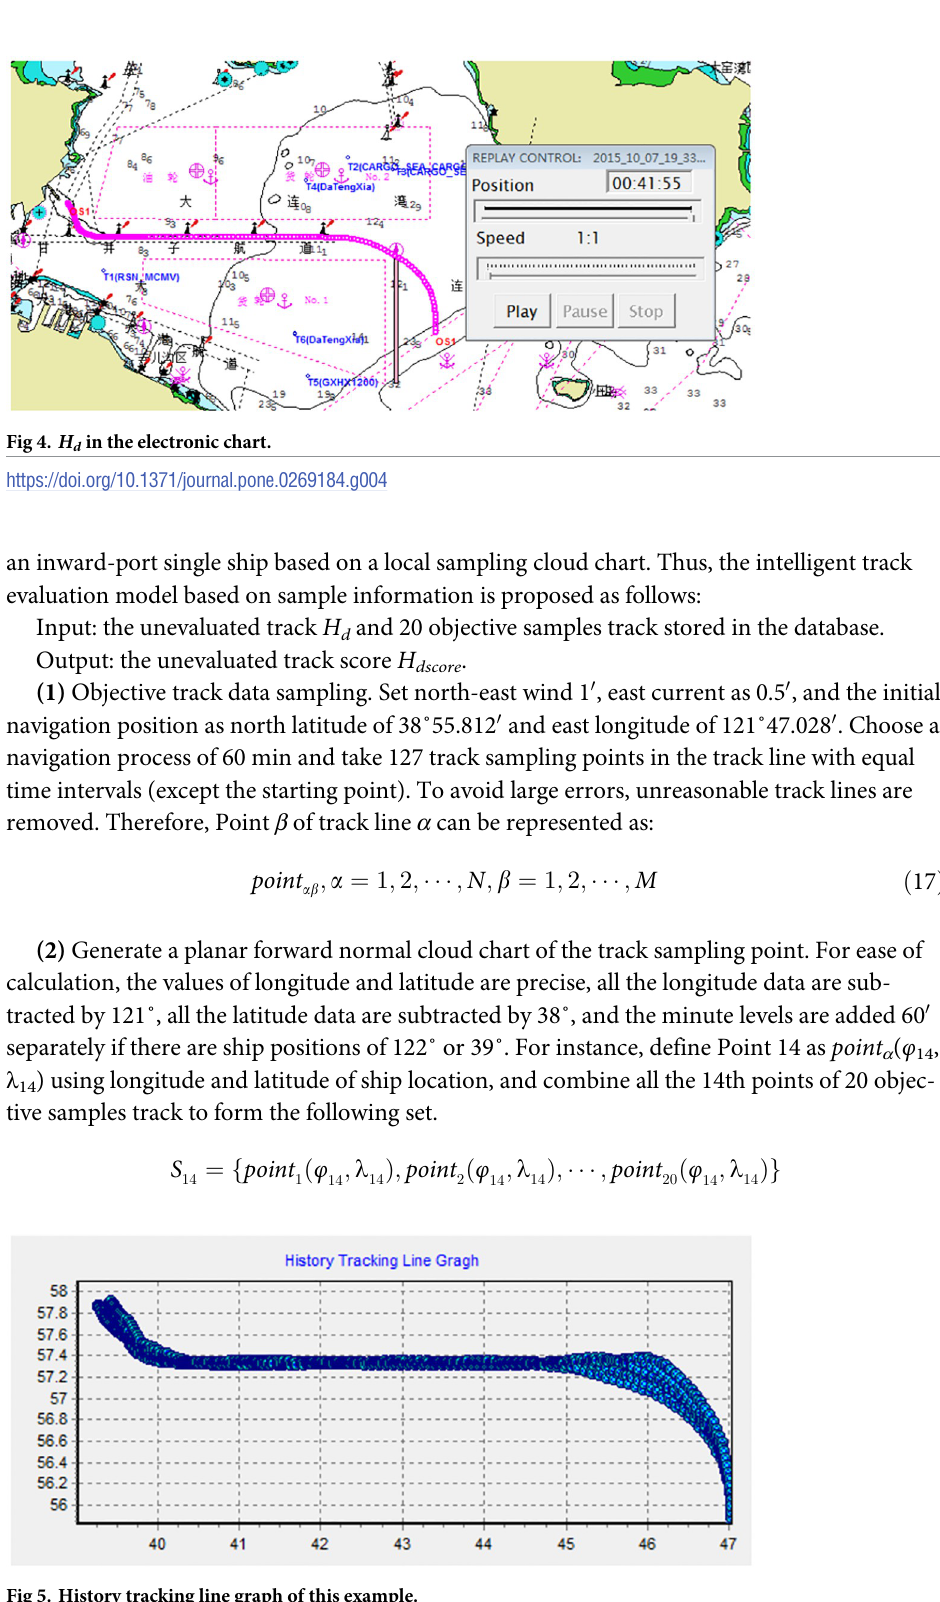
Fig 5. History tracking line graph of this